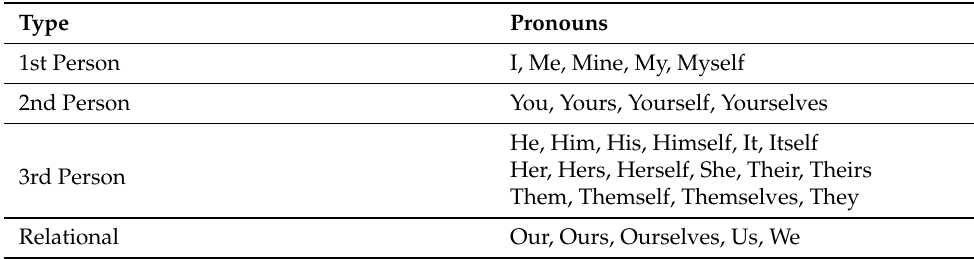
Table 2. List of pronouns used for the natural language